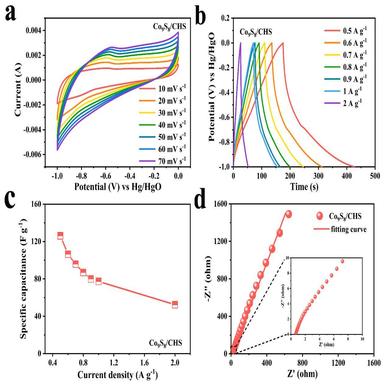
Electrochemical properties of Co9S8/CHS in the negative voltage window; (a) CV curves; (b) GCD curves; (c) the specific capacitance of Co9S8/CHS and (d) Nyquist diagram.